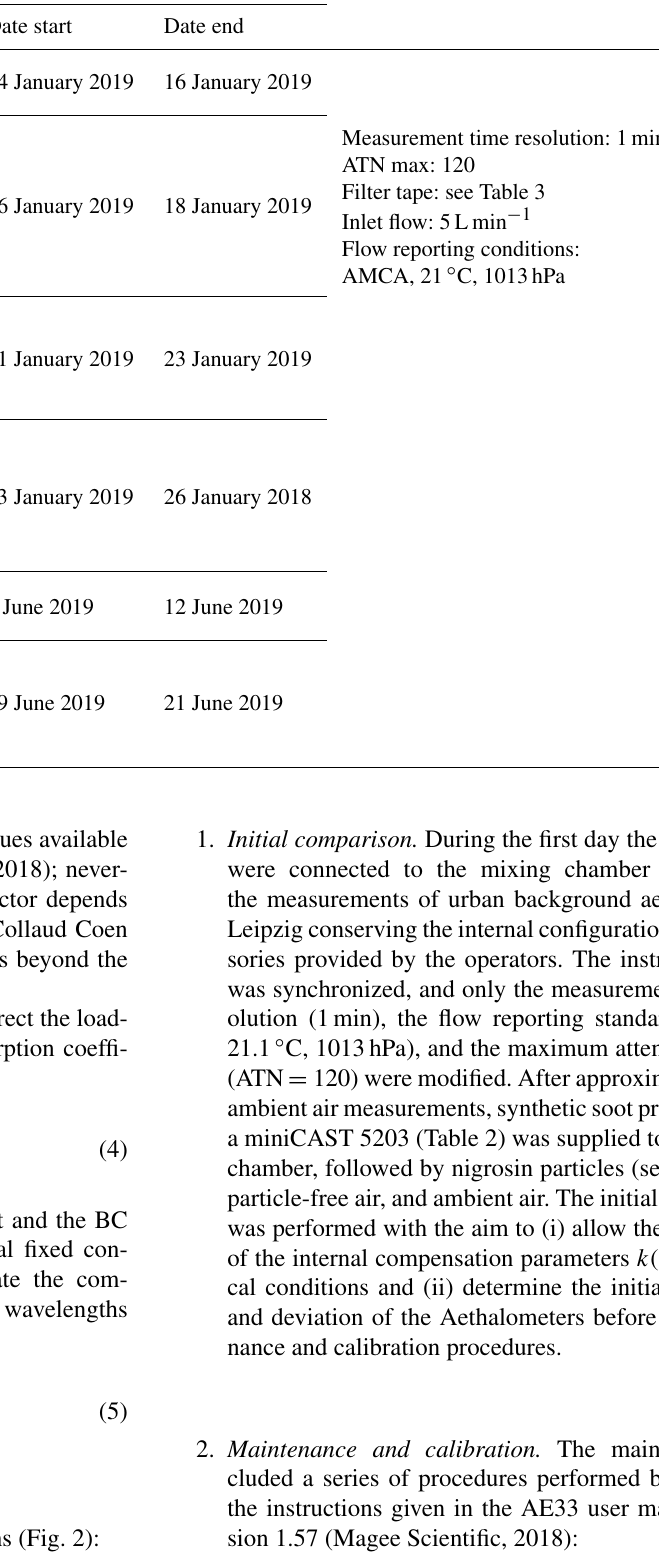
Table 1. List of Aethalometers AE33 intercompared. Group No. ID Serial